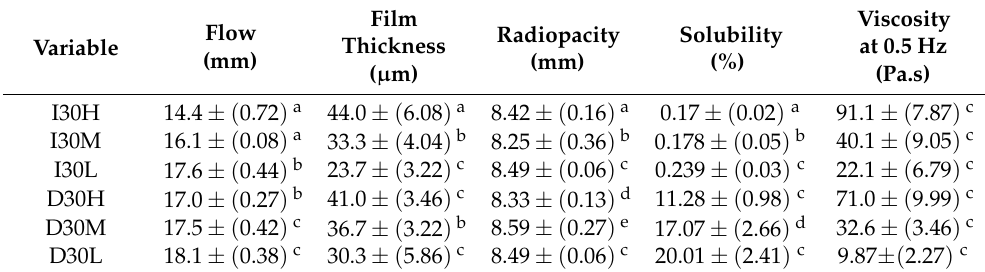
Table 1. Flow, film thickness, radiopacity, solubility, and viscosity at 0.5 Hz. (Mean ± SD). Within each column, the significant differences between groups are indicated by different superscript